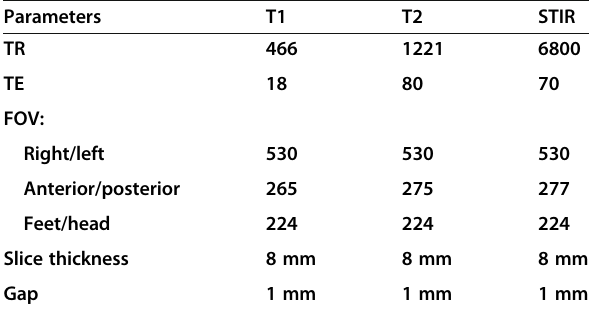
Table 2 Whole body MRI also included Tl and STIR pulse sequences parameters